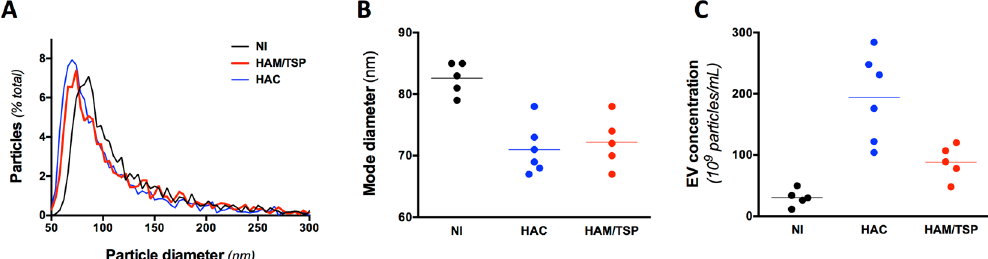
Figure 1. EVs are more abundant and smaller in the plasma of HTLV-1 infected individuals. ( A ) Size distribution of the EV populations. Plasma EVs were isolated on qEV columns and the collected vesicles were studied for size on qNANO. The mean particle size distribution is presented. HD is for healthy donors, HAC for HTLV-1 asymptomatic carriers, and HAM/TSP for patients with HAM/TSP. ( B ) Mode size of plasma EVs. EVs are smaller in the plasma of HTLV-1 infected individuals when compared to NI (p-value = 0,002, Kruskal- Wallis test, Dunn’s post-hoc test). ( C ) EV concentration of the different EV samples. EV concentration was determined with the qNANO device. EV concentration was significantly higher in HAC when compared to